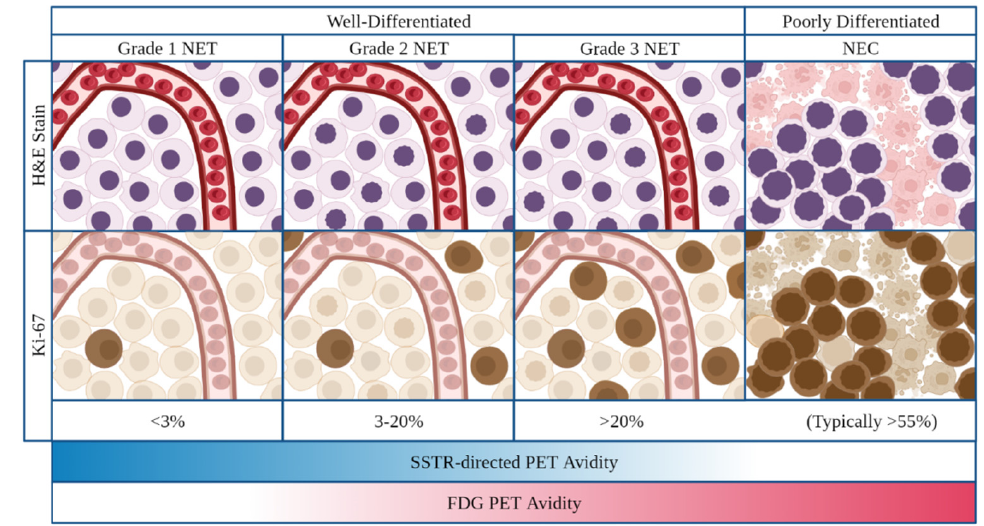
Figure 1. Classification and grading criteria for neuroendocrine neoplasms of the gastrointestinal tract as per 2019 World Health Organization criteria. On H&E and IHC staining, NETs (well-differentiated) demonstrate preserved organoid pattern and infrequent mitotic activity while NECs (poorly differentiated) demonstrate loss of organoid morphology, necrosis, and typically high levels of mitotic activity. On imaging, increasing tumor grade frequently demonstrates an inverse correlation with SSTR-directed PET activity and a direct correlation with FDG-PET activity. Abrreviations: NET neuroendocrine tumor; NEC neuroenocrine carcinoma, H&E hematoxylin and eosin; PET positron emission tomography, FDG fluorodeoxyglucose.